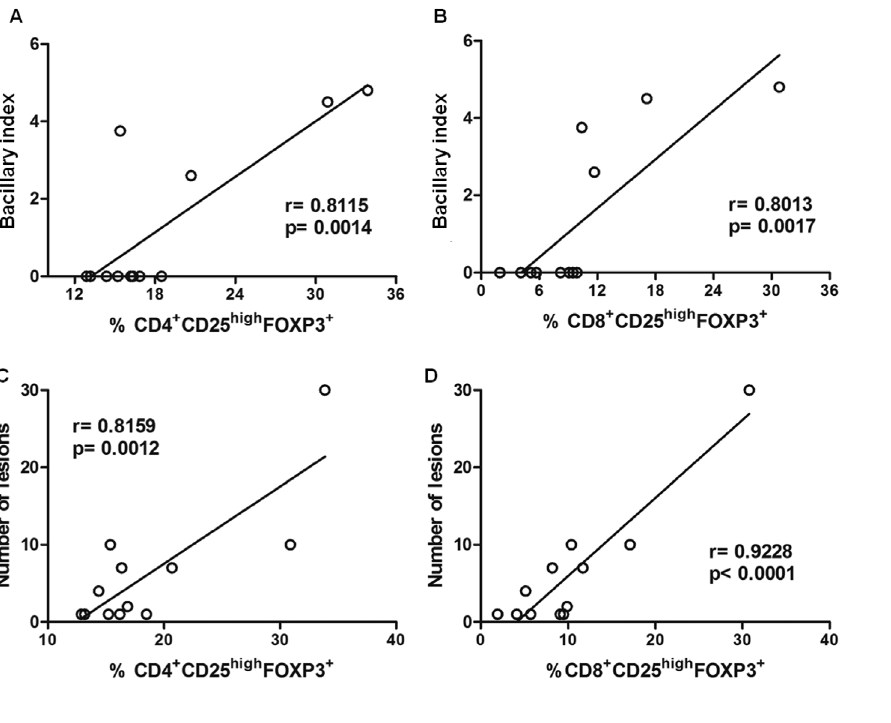
Figure 5. Correlation between CD4 + /CD8 + CD25 high FOXP3 + cells and bacillary index and lesion numbers in leprosy patients. The frequency of CD4 + /CD8 + CD25 high FOXP3 + cells in CD4 + or CD8 + lymphocyte gate was obtained after 72-hour culture of peripheral blood mononuclear cells with anti-CD3 and anti-CD28 associated with total sonicated fraction of M. leprae. Correlation between bacillary index of leprosy patients and CD4 + CD25 high FOXP3 (A) and CD8 + CD25 high FOXP3 (B) Treg frequency. Correlation between lesion numbers in leprosy patients and CD4 + CD25 high FOXP3 (C) and CD8 + CD25 high FOXP3 (D) cell frequency. Pearson test, p # 0.05 was considered significant.